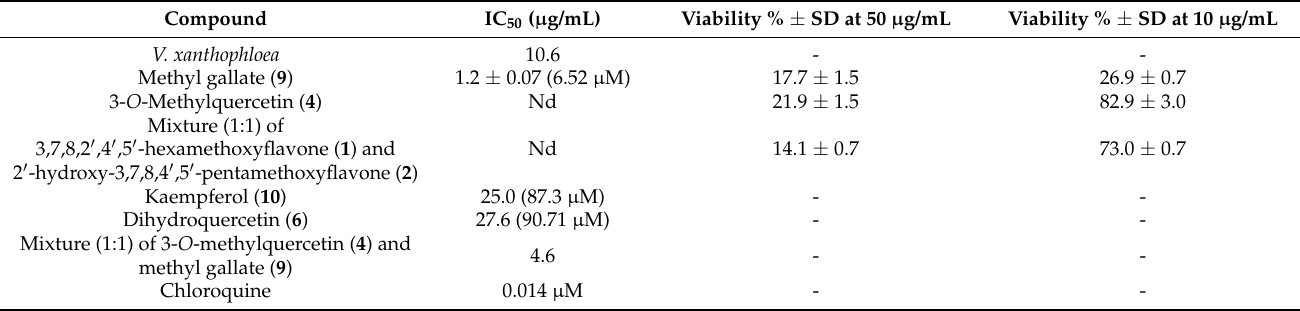
Table 2. In vitro antiplasmodial activity of the extract and a few isolated compounds.